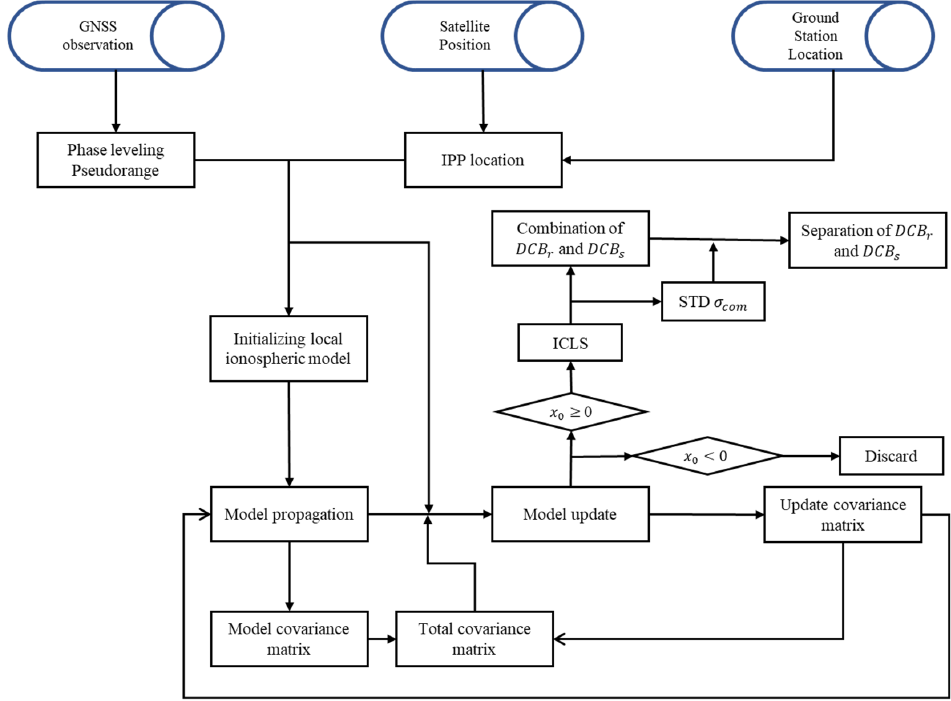
Figure 1. Flowchart of the recursive method.